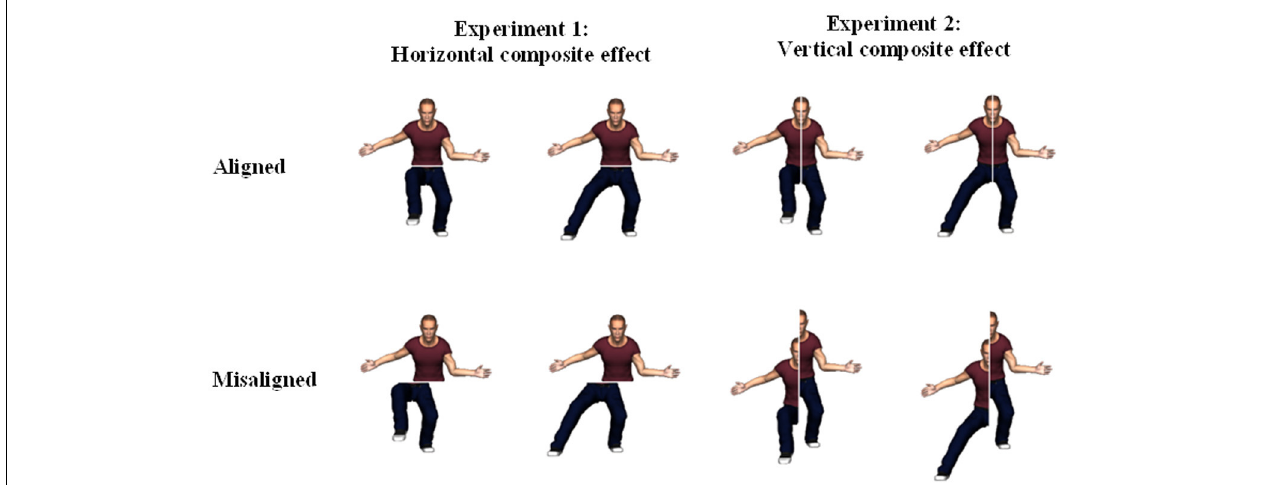
FIGURE 2 | Body composite stimulus pairs for each alignment condition for both experiments. The relevant halves (i.e., top halves and right halves) in all four pairs are depicting an identical pose, while the irrelevant halves (i.e., bottom halves and left halves) differ within a stimulus pair.